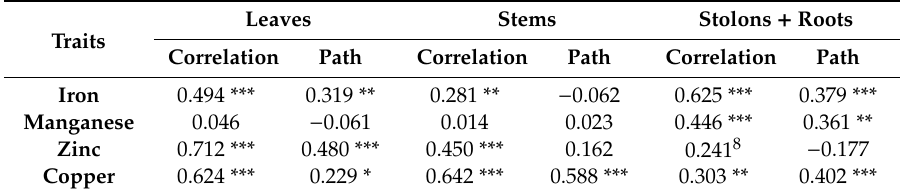
Table 4. Correlation and path coe ffi cients for relationships between micronutrient content and tuber yield ( n =